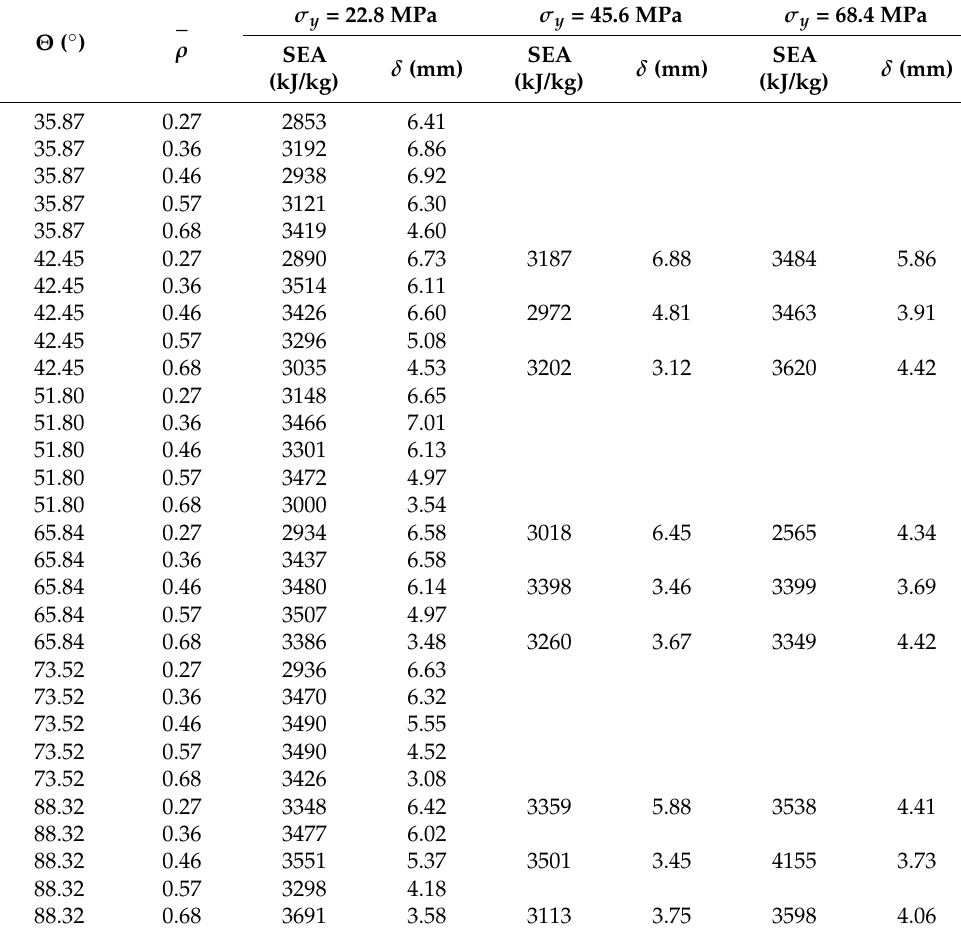
Table 4. Design sample points and numerical results for the structure with different lattice